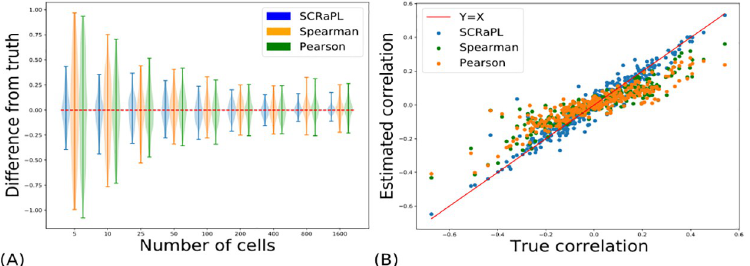
Fig 2. Plots summarizing differences in correlation estimation between SCRaPL, Spearman in Experiment 1 with synthetic data. (2A) Estimated correlation difference from true correlation as a function of cells for SCRaPL, Spearman and Pearson. (2B) Estimated correlation as a function of true correlation for SCRaPL, Spearman and Pearson in synthetic datasets with 300 genes and 1600 cells. Each dot represents a gene and is color-coded based inference